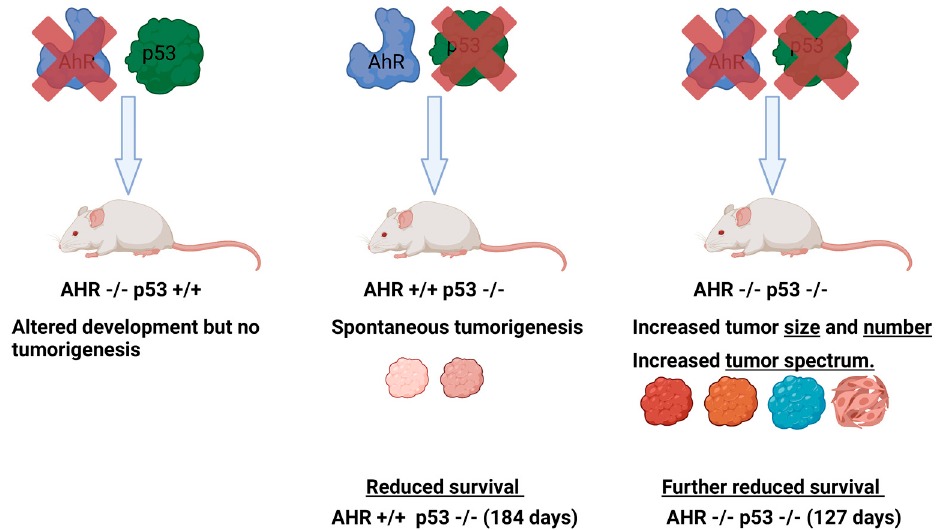
Figure 4. Loss of AhR leads to increased tumorigenesis in p53deficient mice. Diagram representing the relative effects of AhR deletion, p53 deletion, or the deletion of both genes on tumorigenesis, tumor spectrum, and survival. Diagrams and annotations refer directly to experimental data published in [155].